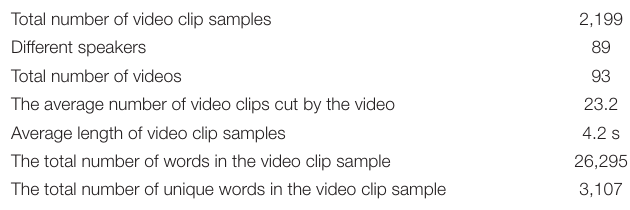
TABLE 1 | Statistical overview of the CMU-MOSI dataset.